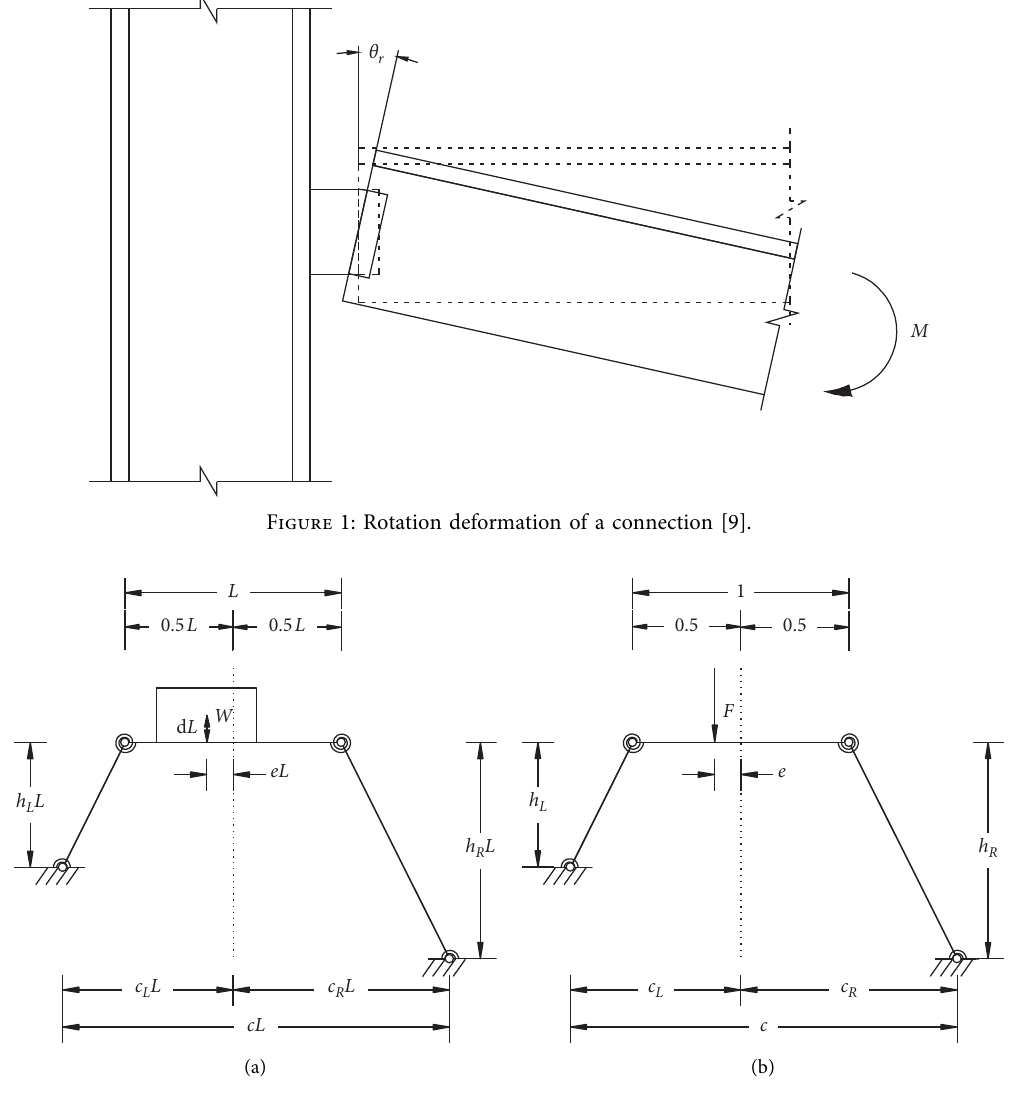
Figure 2: (a) The shape of the asymmetric trapezoidal frame with a load; (b) the geometry of the trapezoidal frame used in the FE simulations whose dimensions have been